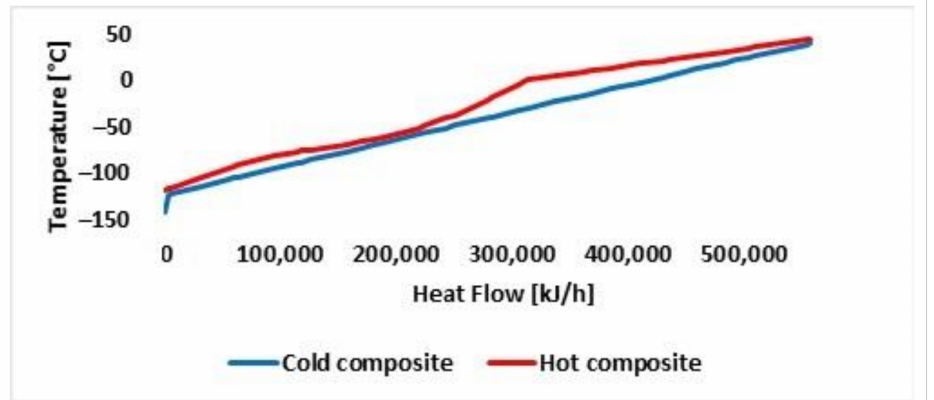
Figure 15. Heat transfer composite curves for AC-2 Cold-Box.